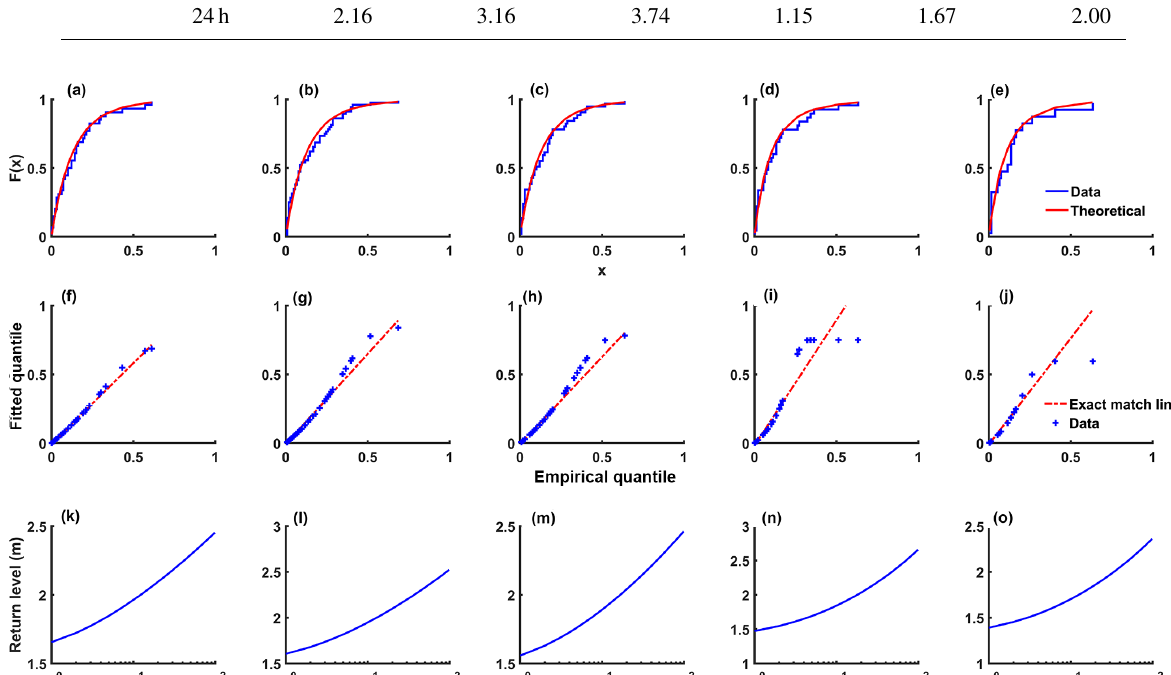
Figure 5. Same as in Fig. 4 but corresponding to the pre-monsoon season.